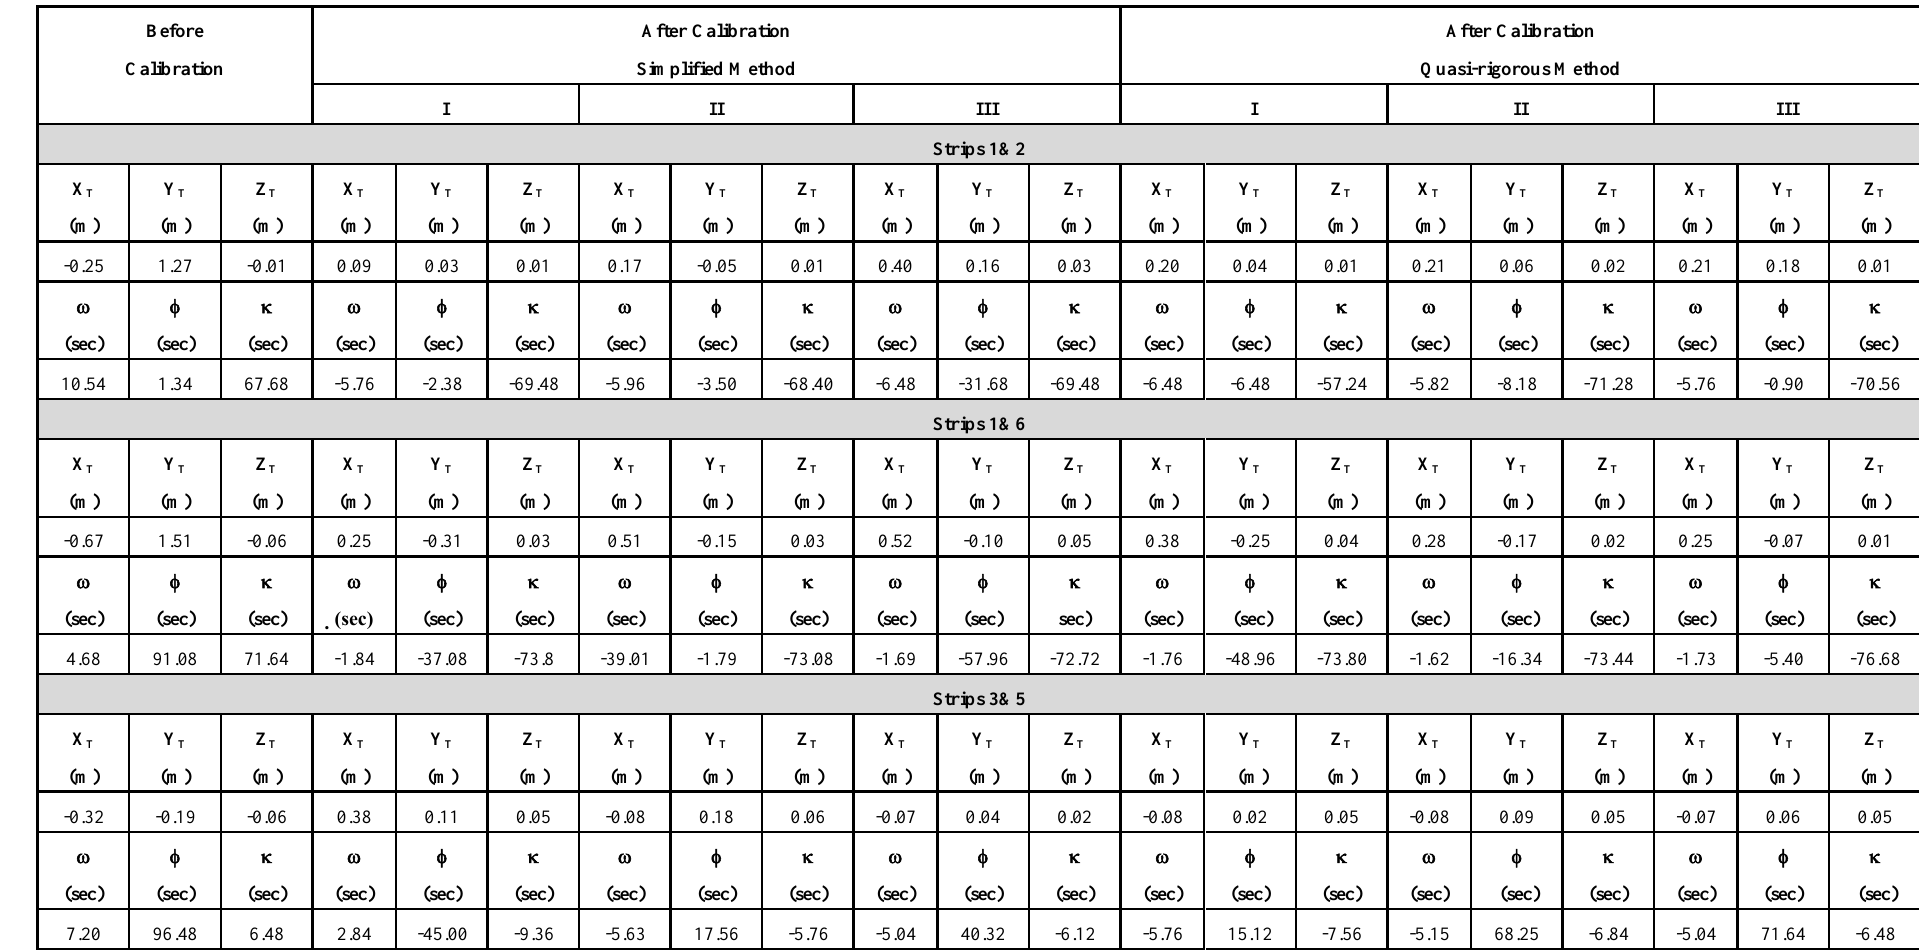
Table 8. Discrepancies between some of the overlapping strip pairs before and after applying the calibration parameters obtained using real data, the Simplified and Quasi-rigorous methods, and the 3 test